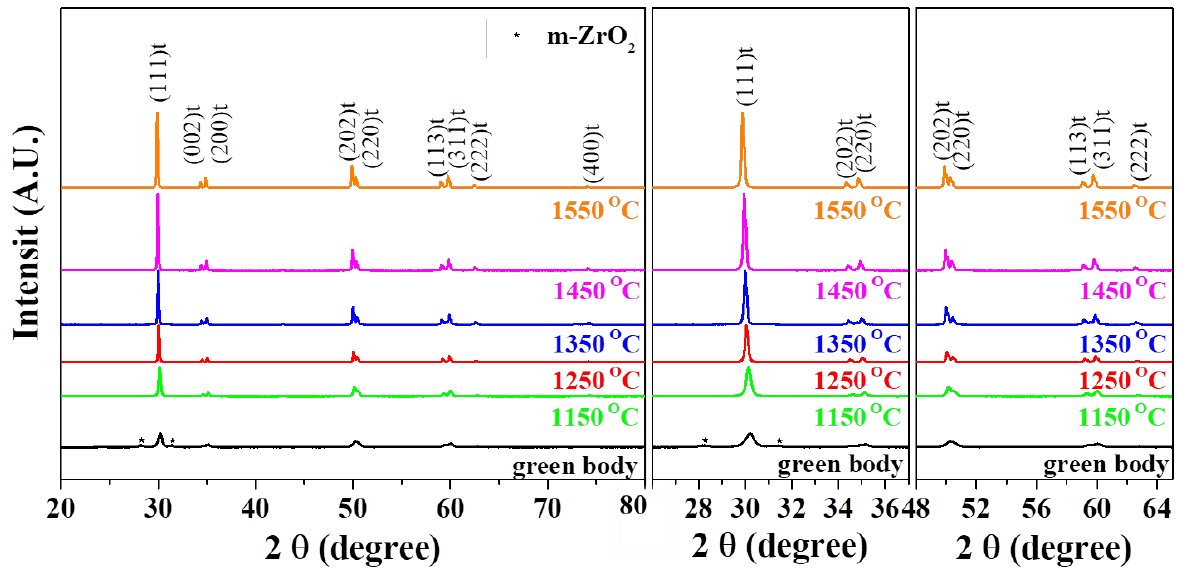
Figure 3. XRD patterns of 3YSZ 3D-printed sintered body according to sintering temperature.